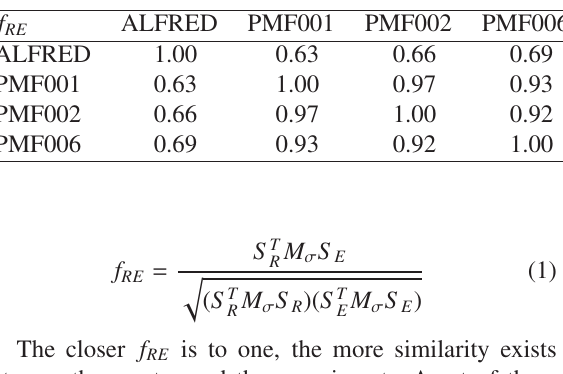
Table 5. Representativity factor of the experiments used in the assimilation for ENDF / B-VIII.0.